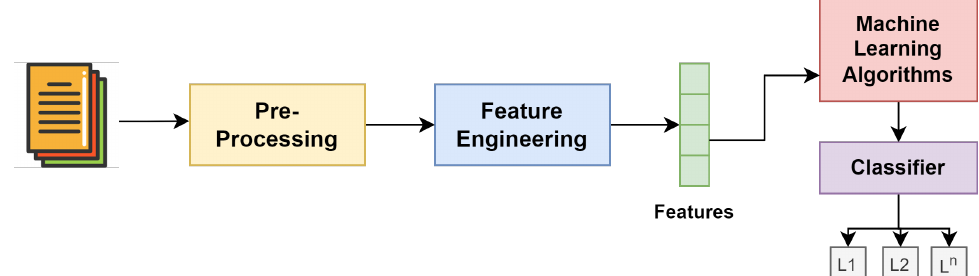
Figure 3. Prediction pipeline of text classification